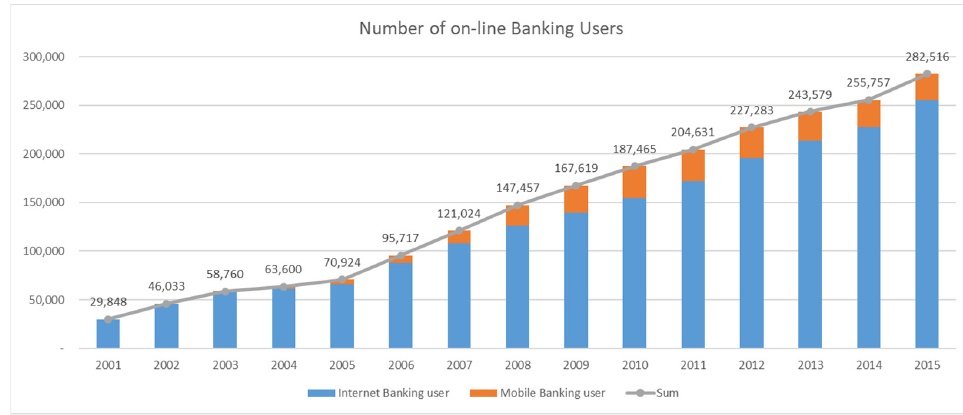
Figure 2. Number of online banking accounts (per 100,000 adults), Korea (2001–2015). Note: The number is counted based on registered accounts. One person may have multiple accounts that are each counted separately. Source: (Bank of Korea 2021).